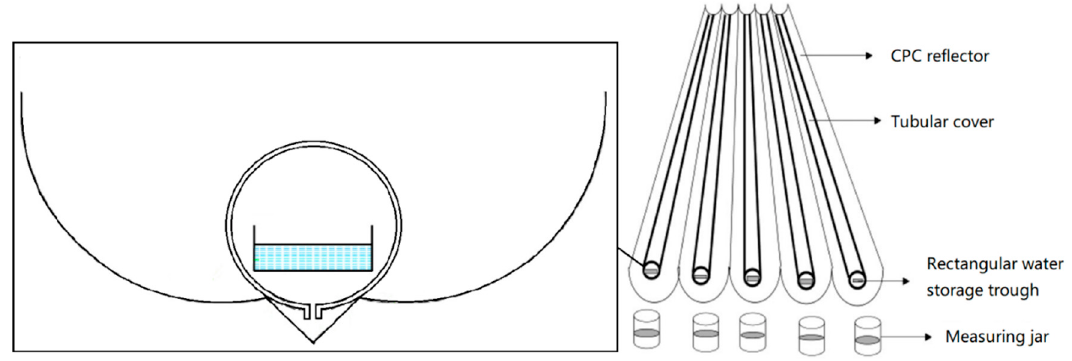
Figure 38. Scheme of the CPC-assisted tubular solar still [73].